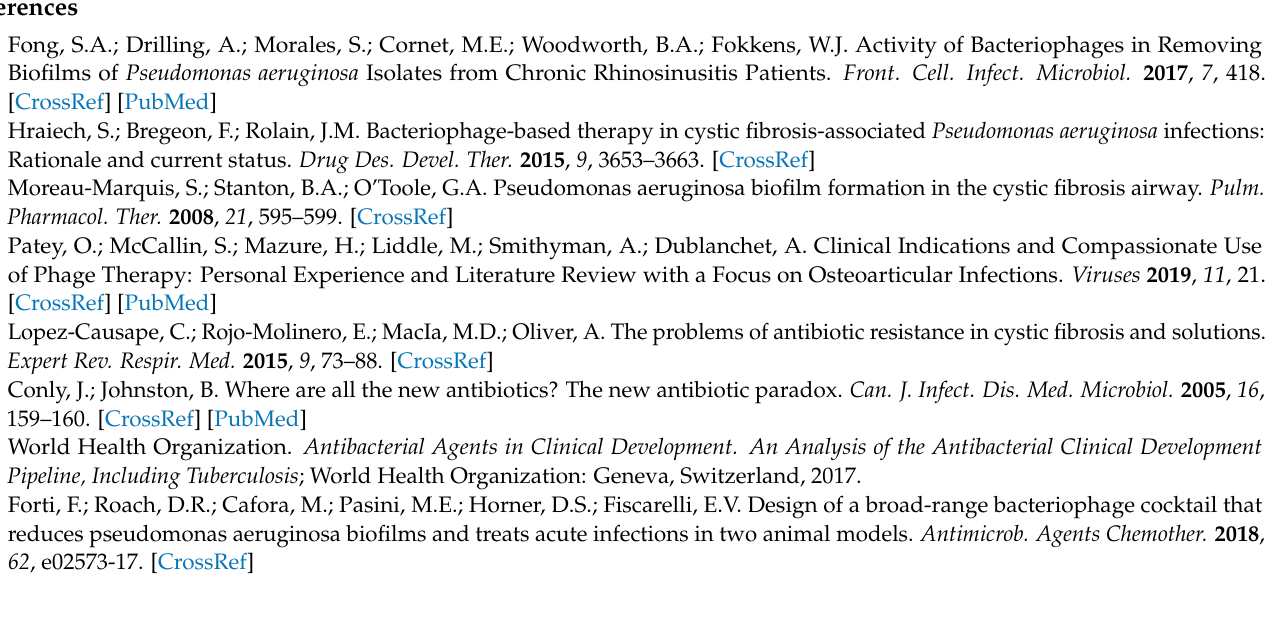
Table S2: Antibiotic Resistance of Clinical Isolates, Figure S1: Bacteriophage pH Stability Test, Figure S2: Bacteriophage Thermal Stability Test, Figure S3: Bacteriophage Long-term Storage Stability Test, Figure S4: (a) C446 biofilm treated with PA4; (b) PA01 biofilm treated with PA4; (c) C462 biofilm treated with